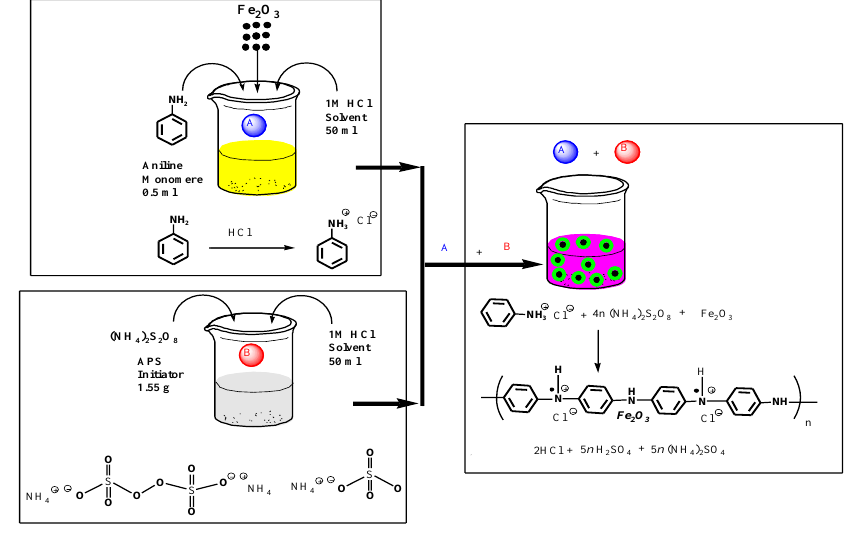
Scheme 4. Schematic representation of synthesis of PANI@Fe 2 O 3 composite by chemical